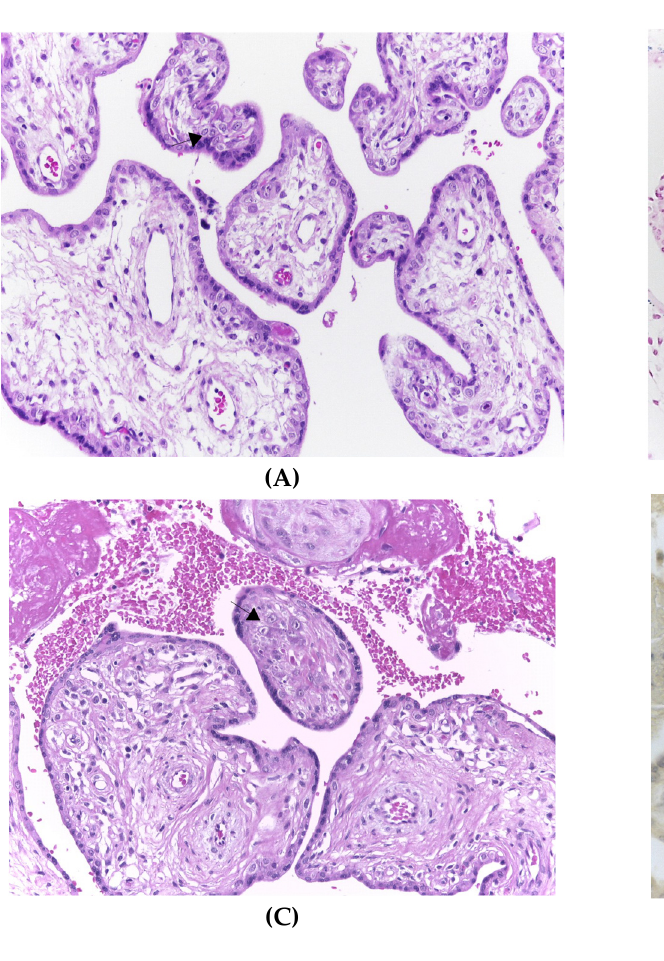
Figure 2. MRI section of fetal brain with arrows displaying lateral ventricular enlargement ( A ) and increased thickness of the germinal matrix ( B ) at 15 weeks of gestation.